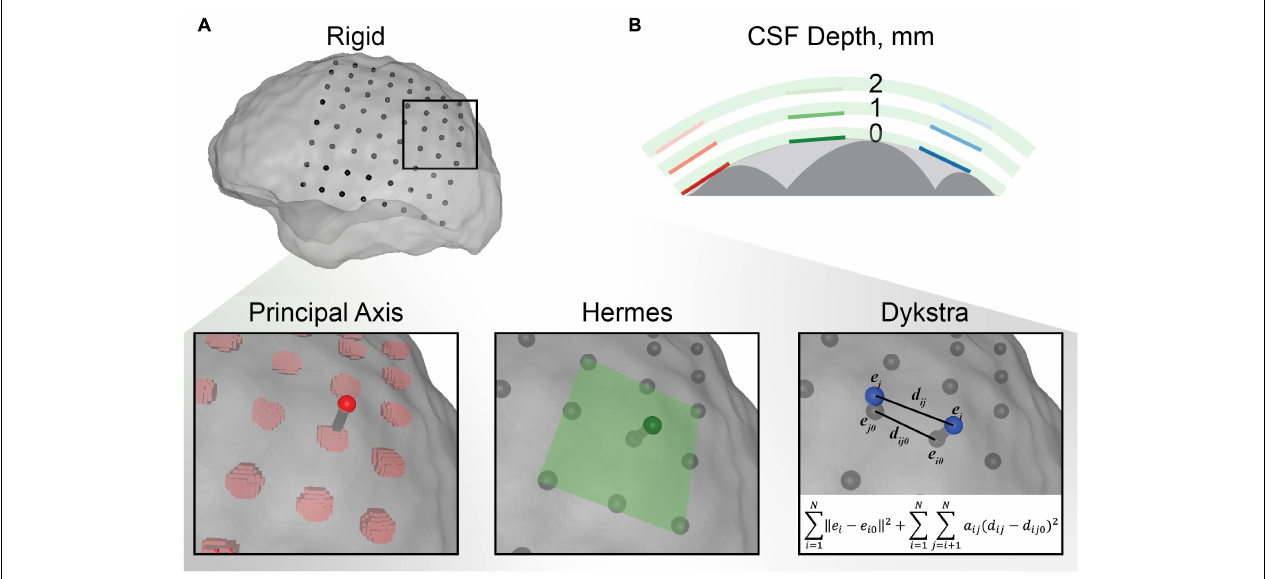
FIGURE 2 | Electrode localization methodology. (A) An example of each electrode projection method for a single electrode in the electrocorticography (ECoG) grid. The centroids for the rigid electrode localizations from the CT are shown in black with respect to the transparent closed gray matter surface used as the final destination for projection. The principal axis method independently projected each electrode centroid along the principal axis of the electrode artifact from the CT. The Hermes method projected each electrode in the direction normal to the plane defined by the electrode and its nearest neighbors. The Dykstra method implemented the shown constrained energy-minimization algorithm. This algorithm minimized both electrode displacement ( (cid:107) e i − e i0 (cid:107) 2 ) and inter-electrode distance deformations ( a ij ( d ij − d ij 0 ) 2 ) where a ij = 1 for neighboring electrodes and 0 for distant electrodes. (B) Schematic representation of the CSF depth below the electrode. Each electrode was modeled with 0, 1, and 2 mm of CSF between the electrode and closed gray matter surface (the surface boundary of the light gray area) for each electrode projection method. The gray matter is shown in dark gray and the insulating grid is shown in green for each CSF depth.